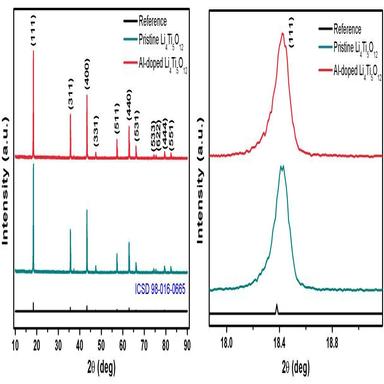
) The XRD pattern of samples; and (b) extended XRD pattern of plane (111).